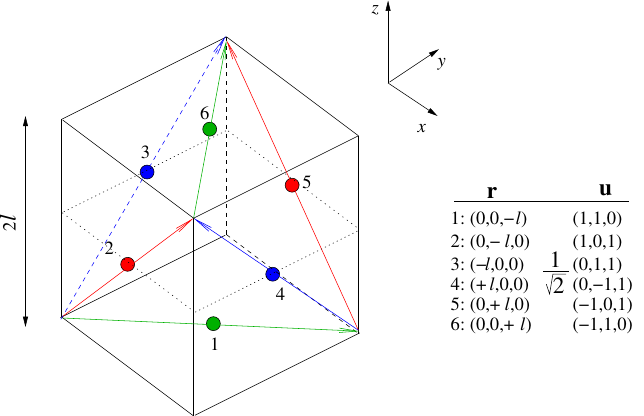
Figure 3. GF-INS cube configuration [12,15,16]. Six uniaxial accelerometers are placed on the faces of a cube of size 2 (cid:96) with their sensitive axes oriented across the diagonals of each face. r and u are the accelerometers’ positions and directions, respectively. They are assumed to be free of